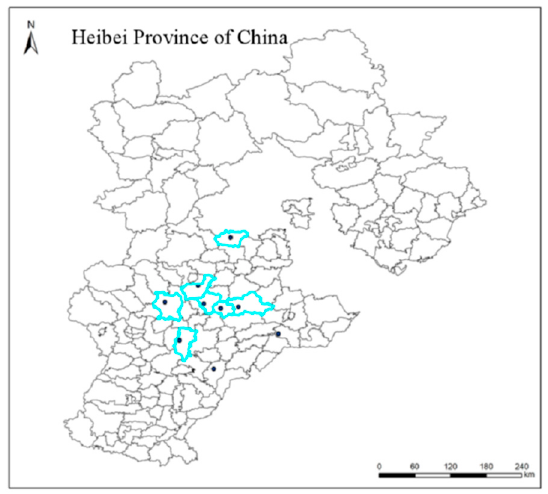
Figure 1. The collection areas of soil samples in Hebei province of China. Table 1. The basic soil physical and chemical properties of collected soil samples.